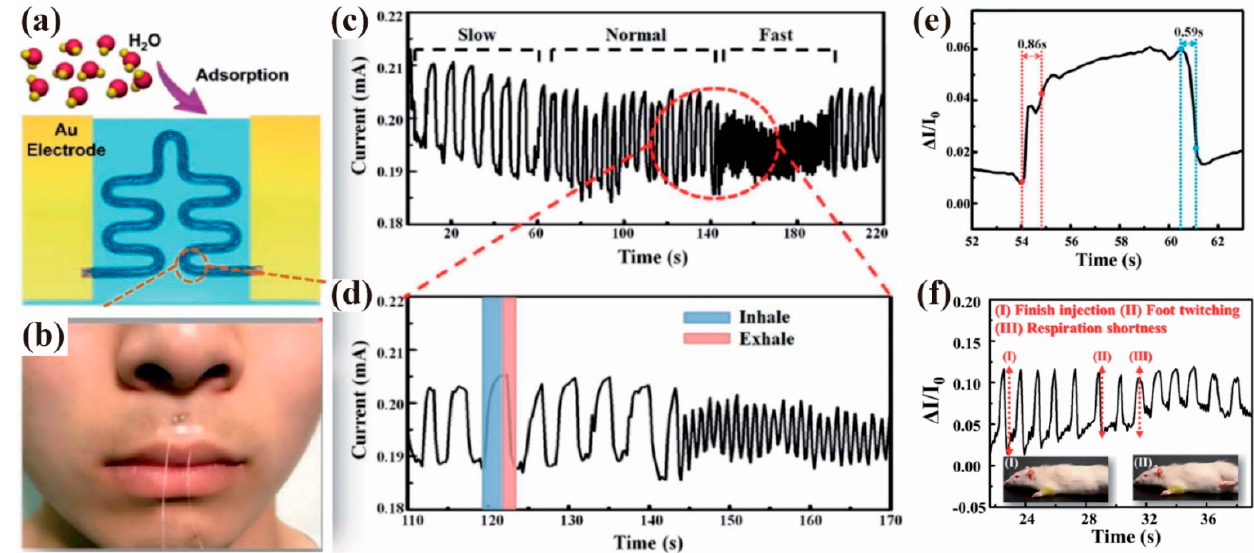
Figure 7. ( a ) Working scheme of the PEDOT:PSS micron line humidity sensor; ( b ) photograph of the PEDOT:PSS micron line humidity sensor put on the skin under nose; ( c ) responses of the sensor at different respiratory rate; ( d ) zoom-in view of ( c ) curve in the linear coordinate system; ( e ) the response and recovery curve after switching 69% RH to the ambient atmosphere (RH was approximately 42%); ( f ) respiratory monitoring curves of anesthetized rat before and after injection of nikethamide [71].